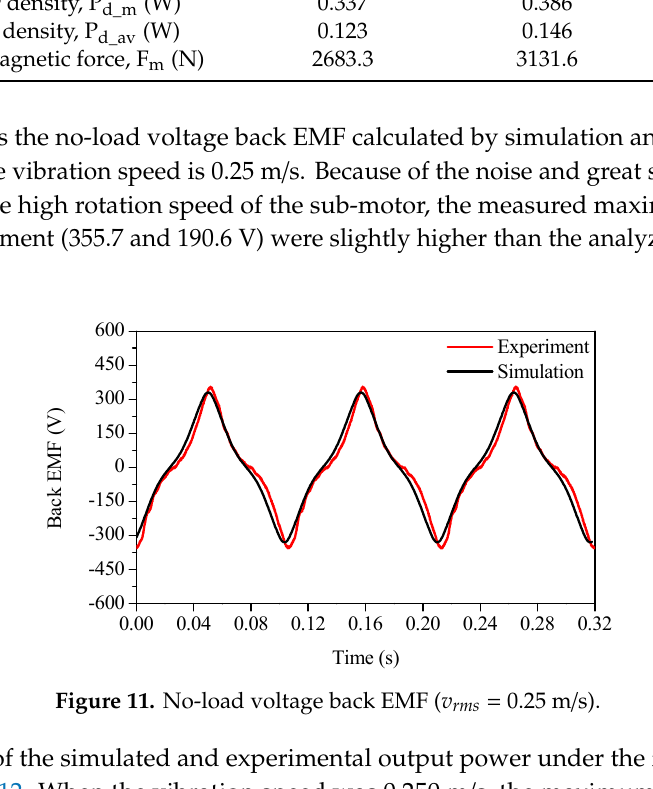
Figure 11. No-load voltage back EMF ( v rms = 0.25 m/s).